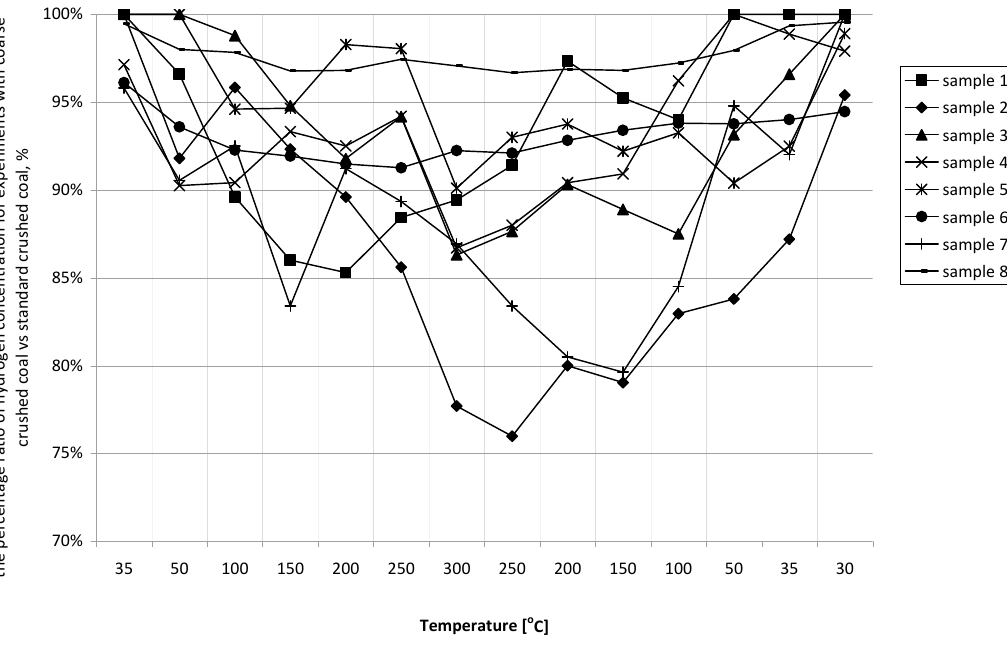
Figure 9. The course of changes in the ratio of released hydrogen (for both coarse and standard crushing) in the stages of heating and cooling of coal samples.